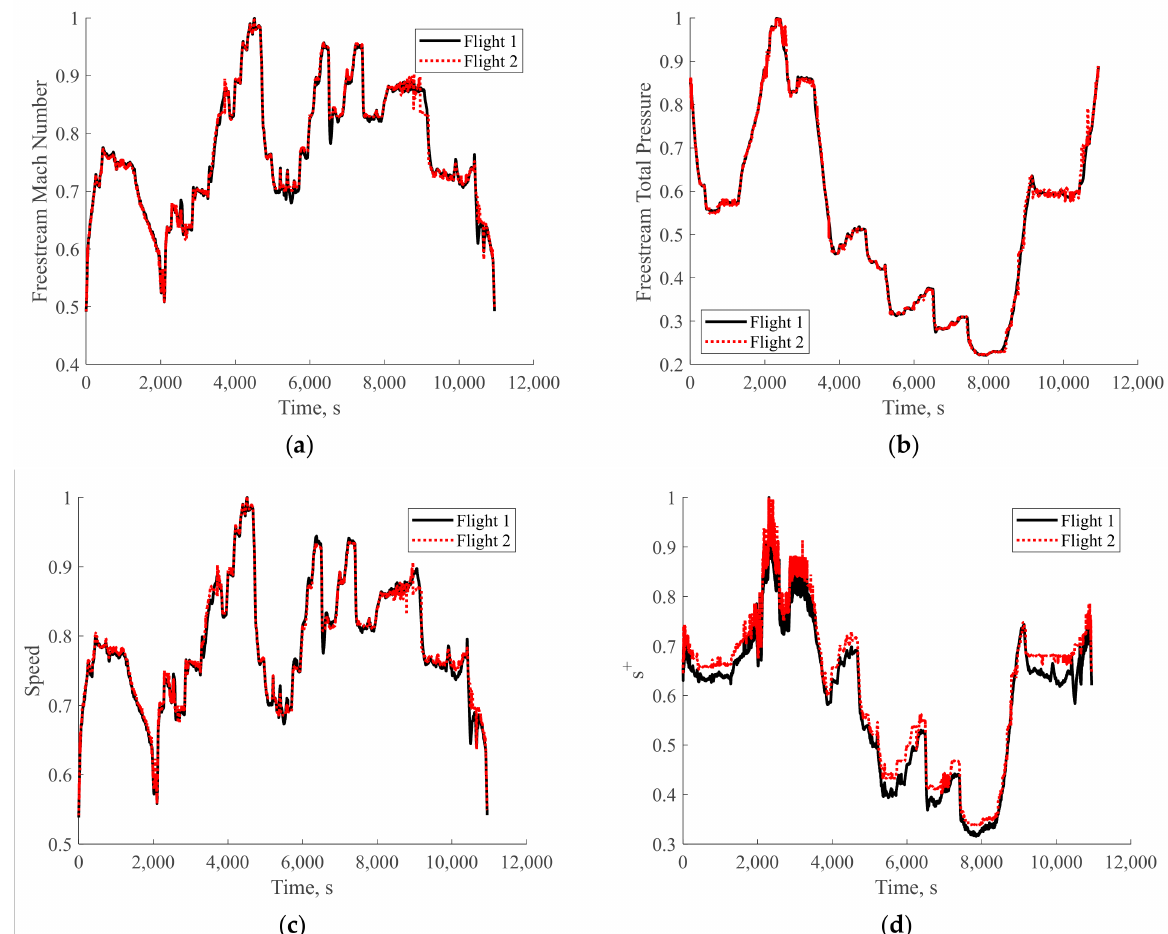
Figure 8. Time-series datasets comparing each reference and compared case found by residual-norm calculations with four variables: ( a ) M ∞ ; ( b ) P 0 ∞ ; ( c ) V ∞ ; and ( d ) s + . Each variable was normalized by its maximum